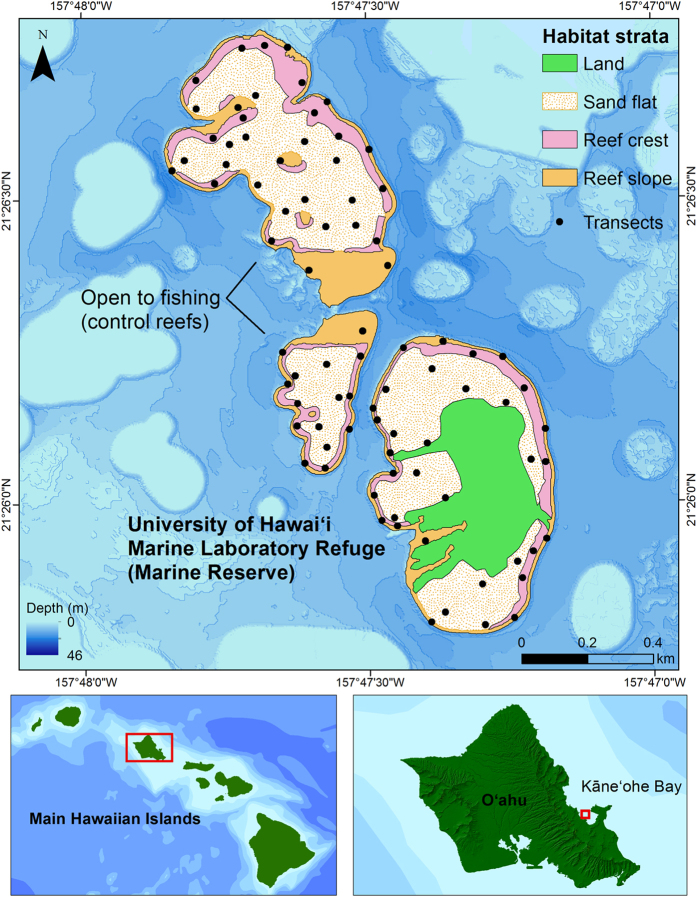
Study area in the south end of Kāne’ohe Bay showing reserve and control reefs as well as habitat strata and transects.Map was created using ESRI ArcMap 10.1, http://www.esri.com/software/arcgis/arcgis-for-desktop.